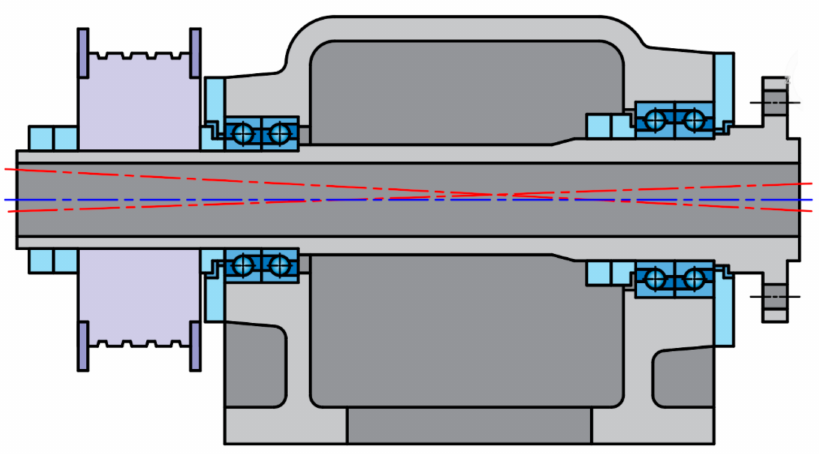
Figure 1. An exemplary schematic drawing of a CNC lathe spindle headstock assembly with a marked structural axis (blue) and two exemplary positions of the instantaneous axis of rotation